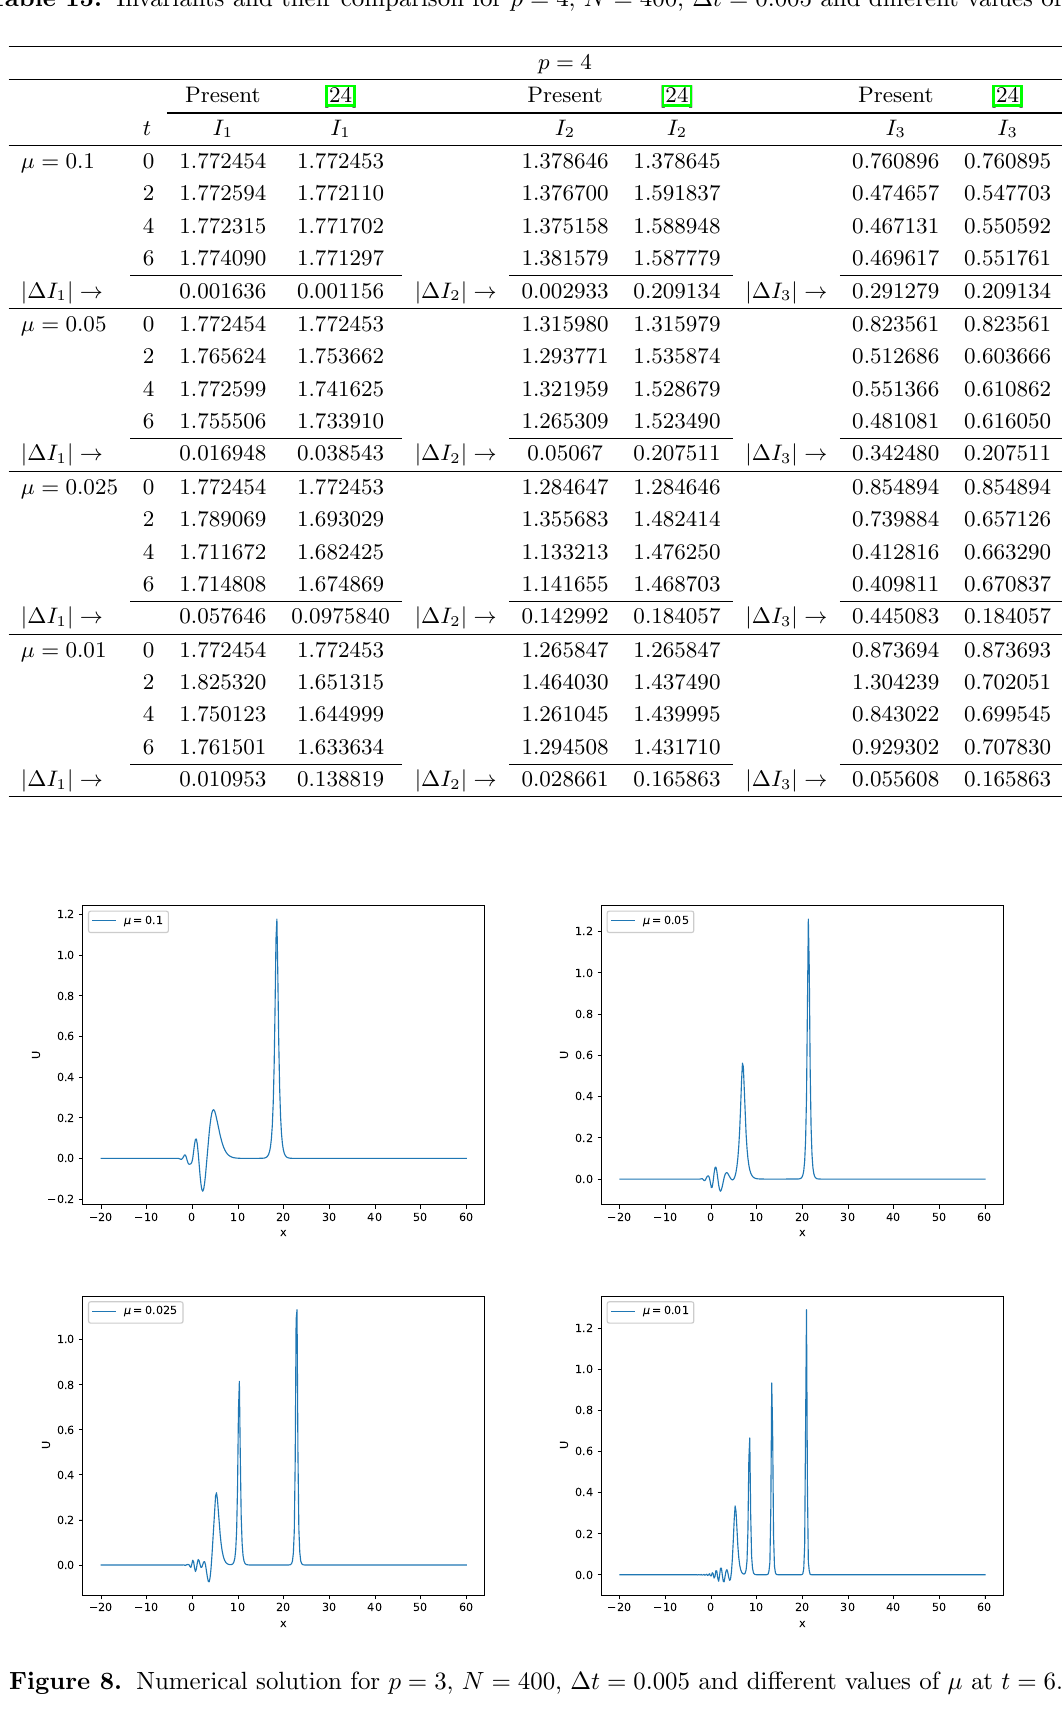
Table 15. Invariants and their comparison for p = 4 , N = 400, ∆ t = 0 . 005 and different values of µ